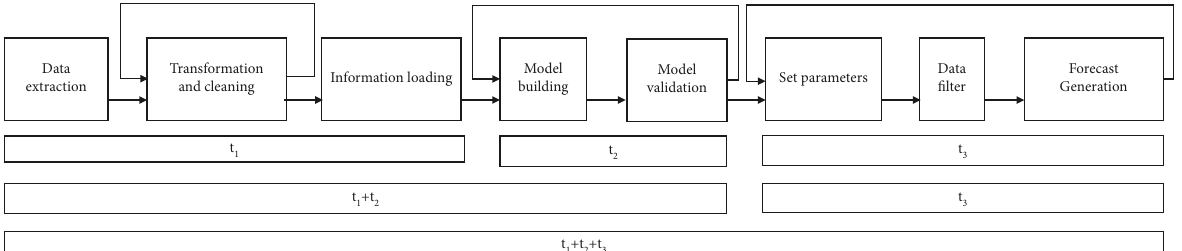
Figure 8: Linear execution diagram of the proposed